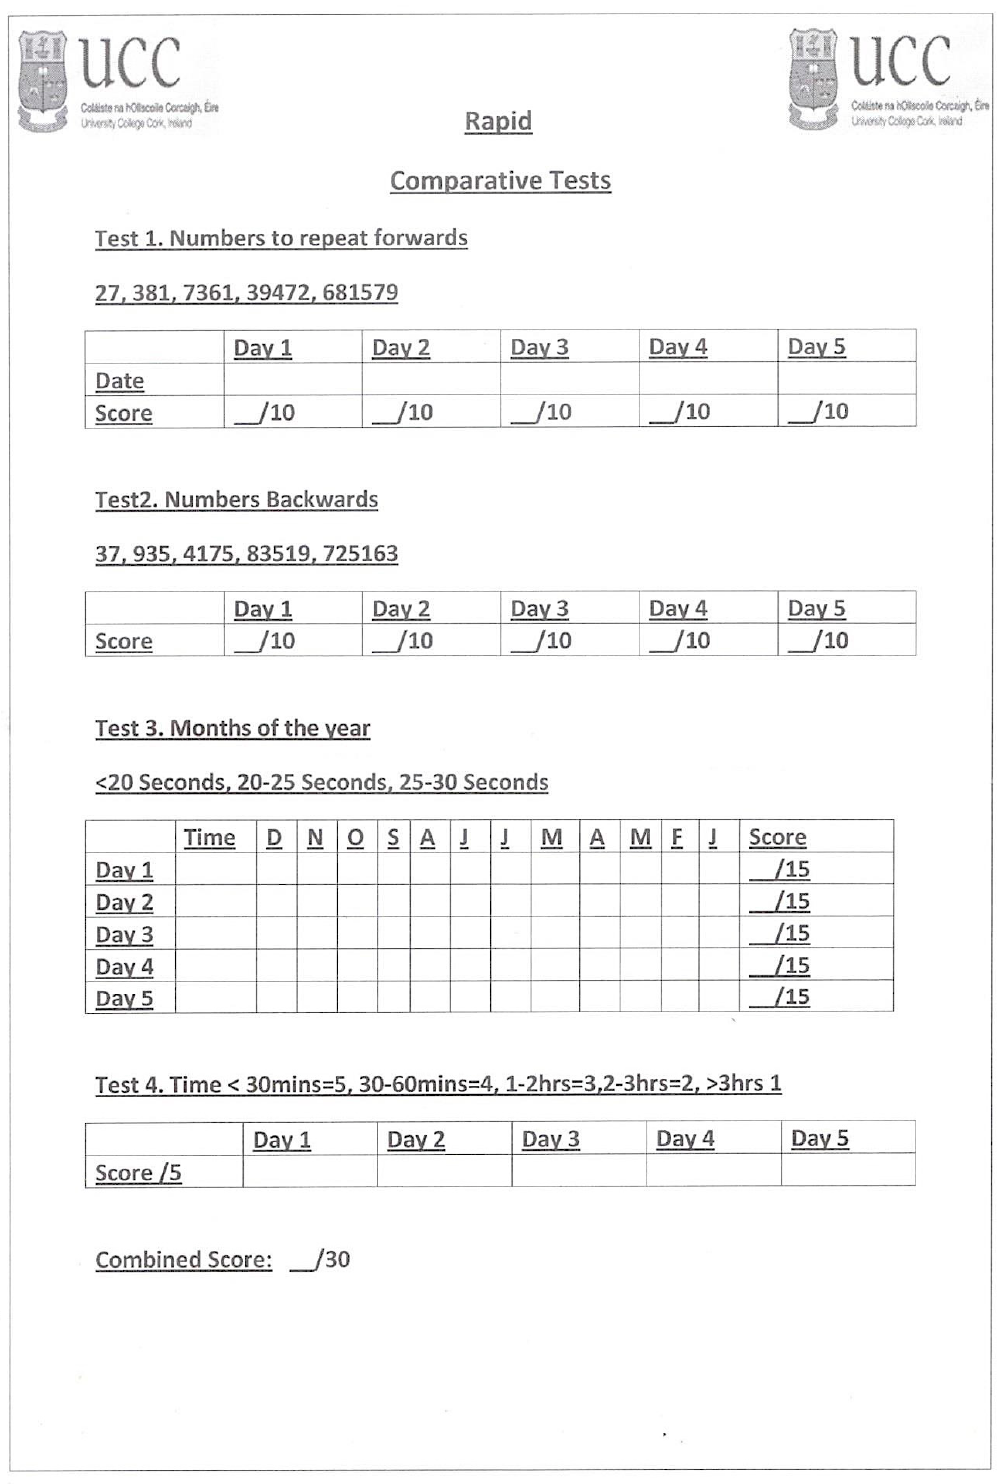
Figure A1. Outcome measures including logical memory test score sheets with alternative versions.